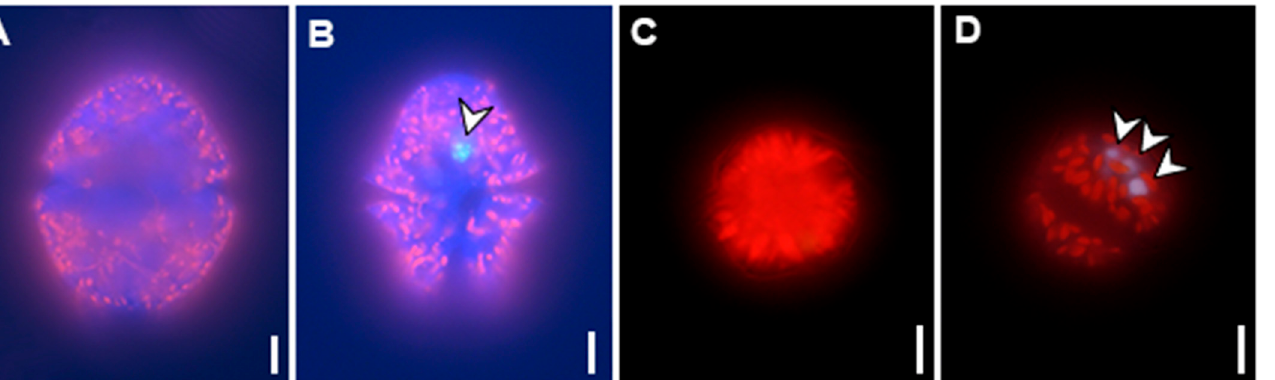
Figure 4. SEM images of LV-sIPN treated algae ( A ) Akashiwo sanguinea , ( B ) Alexandrium pacificum . Figure 5A represents the mean cell number of Ak. sanguinea and A. pacificum during treatment with LV-sIPN NP at 0 h and 24 h under light-to-dark conditions. After 24 h of NP treatment to Ak. sanguinea , the number of cells retained by 64%. The cells containing LV-sIPN NP among living cells were 95% of the total as shown in Figure 5B. While A. pacificum retained by 94% after LV-sIPN NP treatment, it was observed that only 7.93% of cells had uptake of LV-sIPN NP. Ak. sanguinea showed higher uptake ability com- pared to A. pacificum cells due to ornamented theca on the cell outer layer. We chose Ak. sanguinea for further laser treatment investigation due to higher NP uptake ability.